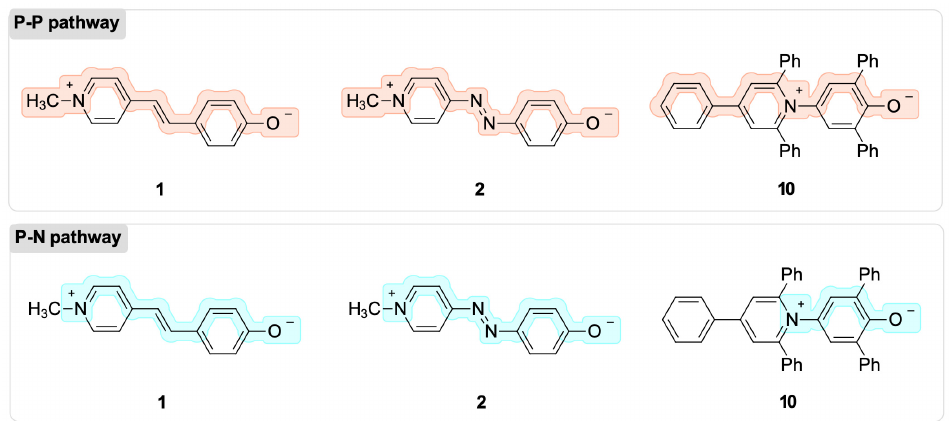
Figure 4. The two molecular pathways employed for the computation of the BLA and BOA indices for dyes 1 , 2 , and 10 , which are representative examples of inverted, positive, and negative solvatochromism, respectively.